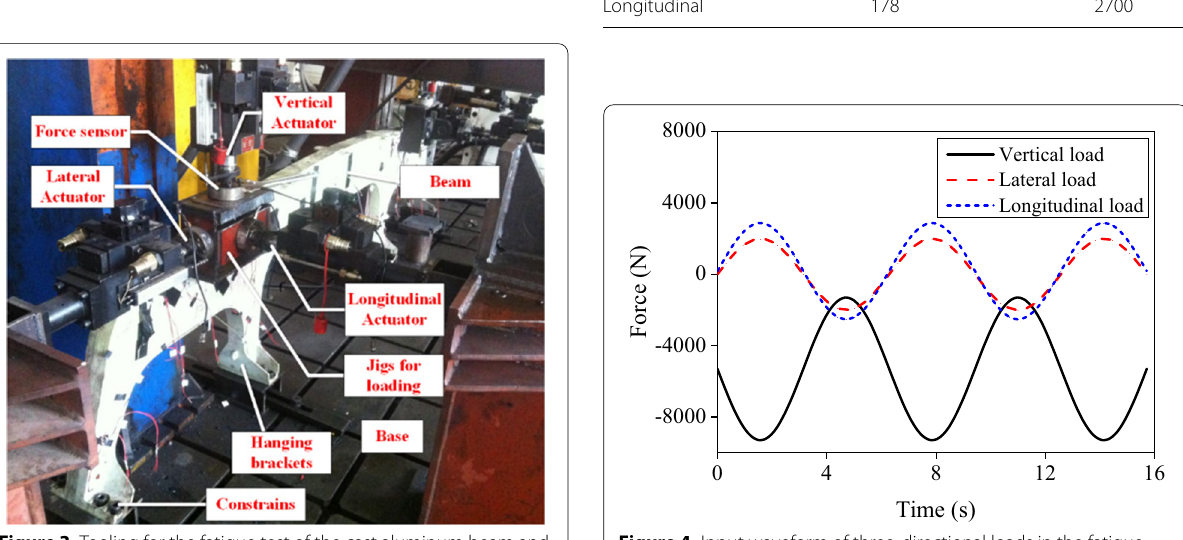
Figure 4 Input waveform of three-directional loads in the fatigue